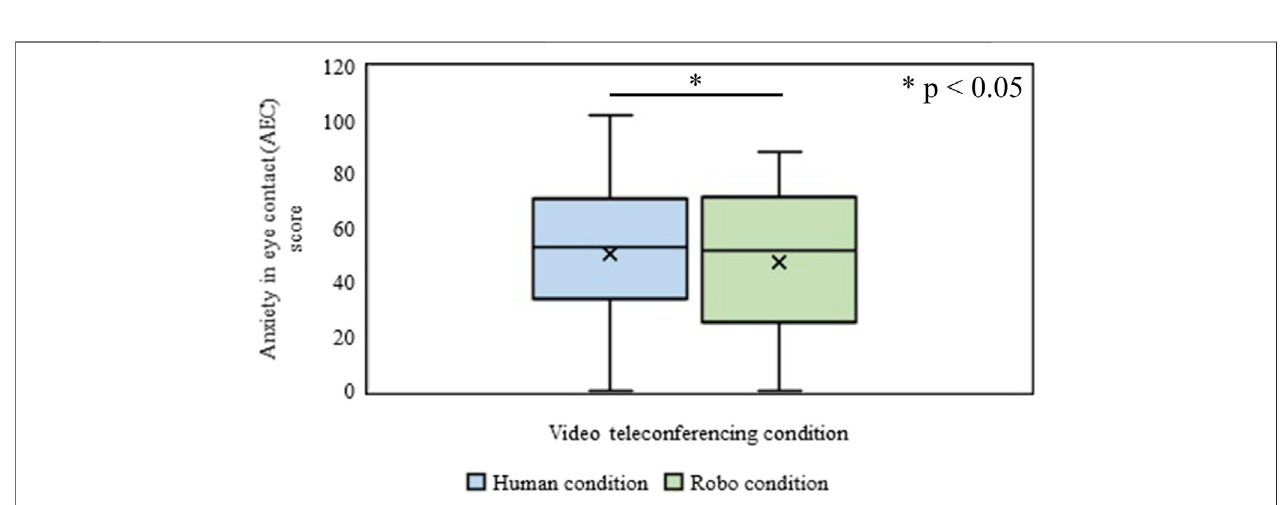
Frontiers in Robotics and AI |